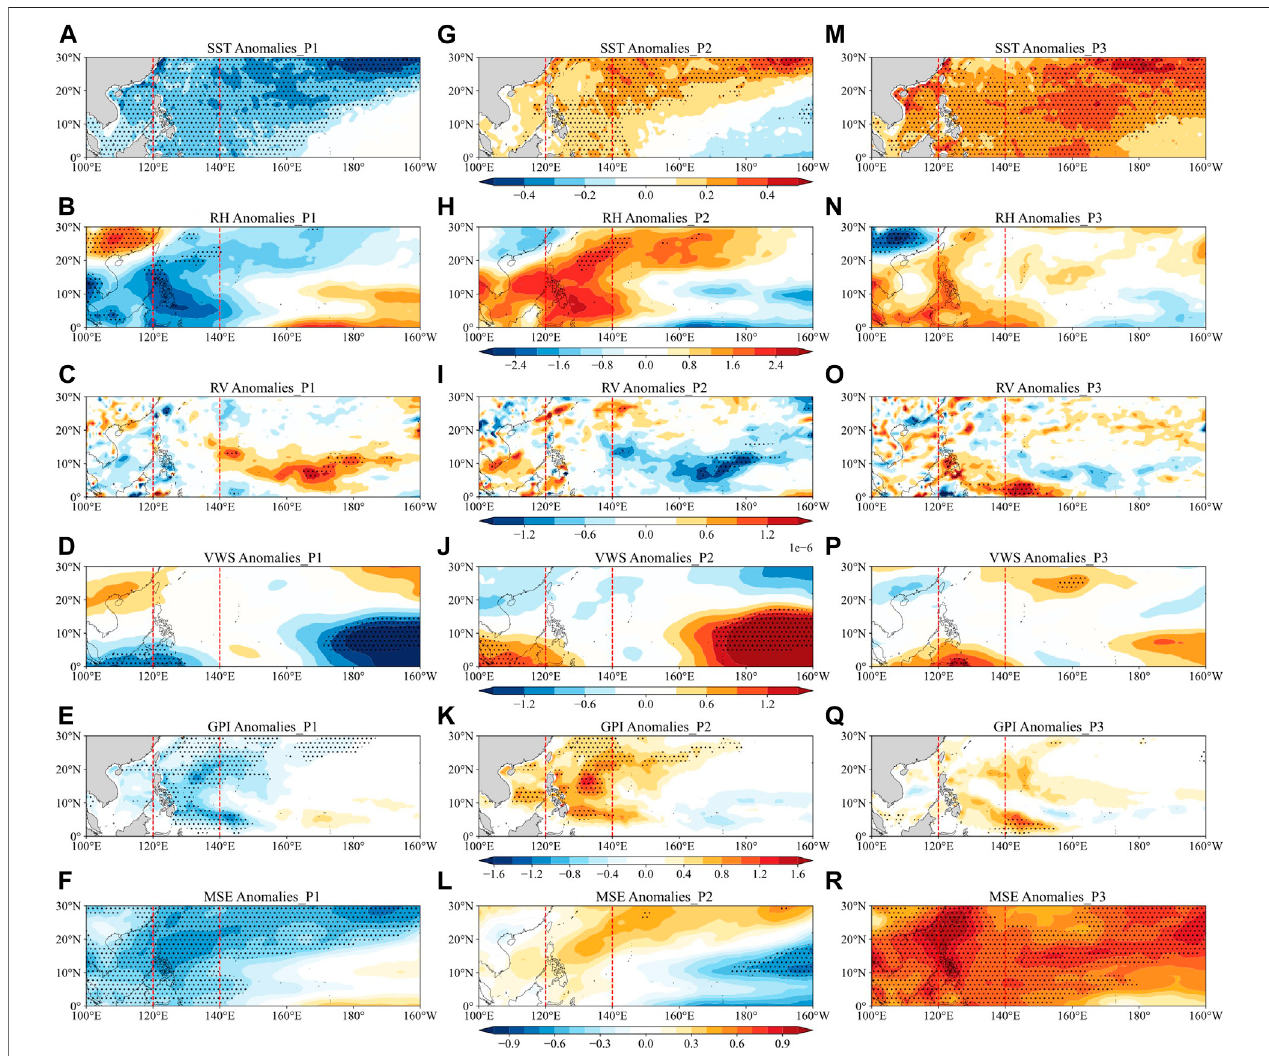
FIGURE 6 | The anomalies of SST, 600 hPa RH, 850 hPa RV, 850 – 200 hPa VWS, GPI, and MSE. (A – F) are the environmental conditions in P1; (G – L) are the environmentalconditionsinP2; (M – R) aretheenvironmentalconditionsinP3.Thereddashedlinesrefertolongitude=120 ° Eand140 ° E,whichseparateWNPintoSCS, WNP1, and WNP2. The black dots are statistically signi fi cant at the 90% con fi dence level.